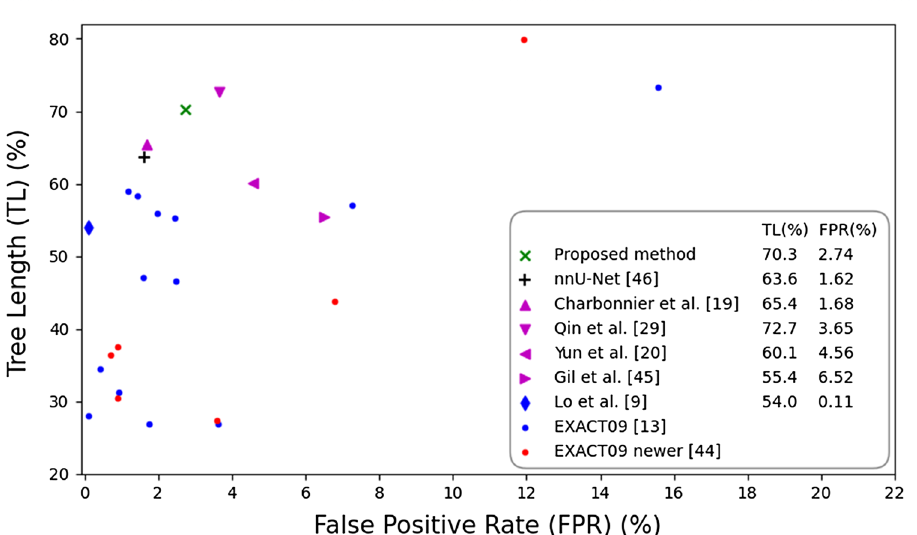
Figure 7. Average tree length detected versus average false positive rate over EXACT’09 test set, for our U-Net- based method, the 15 methods from the challenge EXACT’09 13 , the 6 post-challenge methods 44 , the 4 recent methods 19,20,29,45 evaluated on the EXACT’09 data, and our experiment with the nnU-Net method 46 on these data. Results are computed by the EXACT’09 challenge organizers except for 19 , who did the evaluation slightly differently, leading to slightly better performance, as reported in their